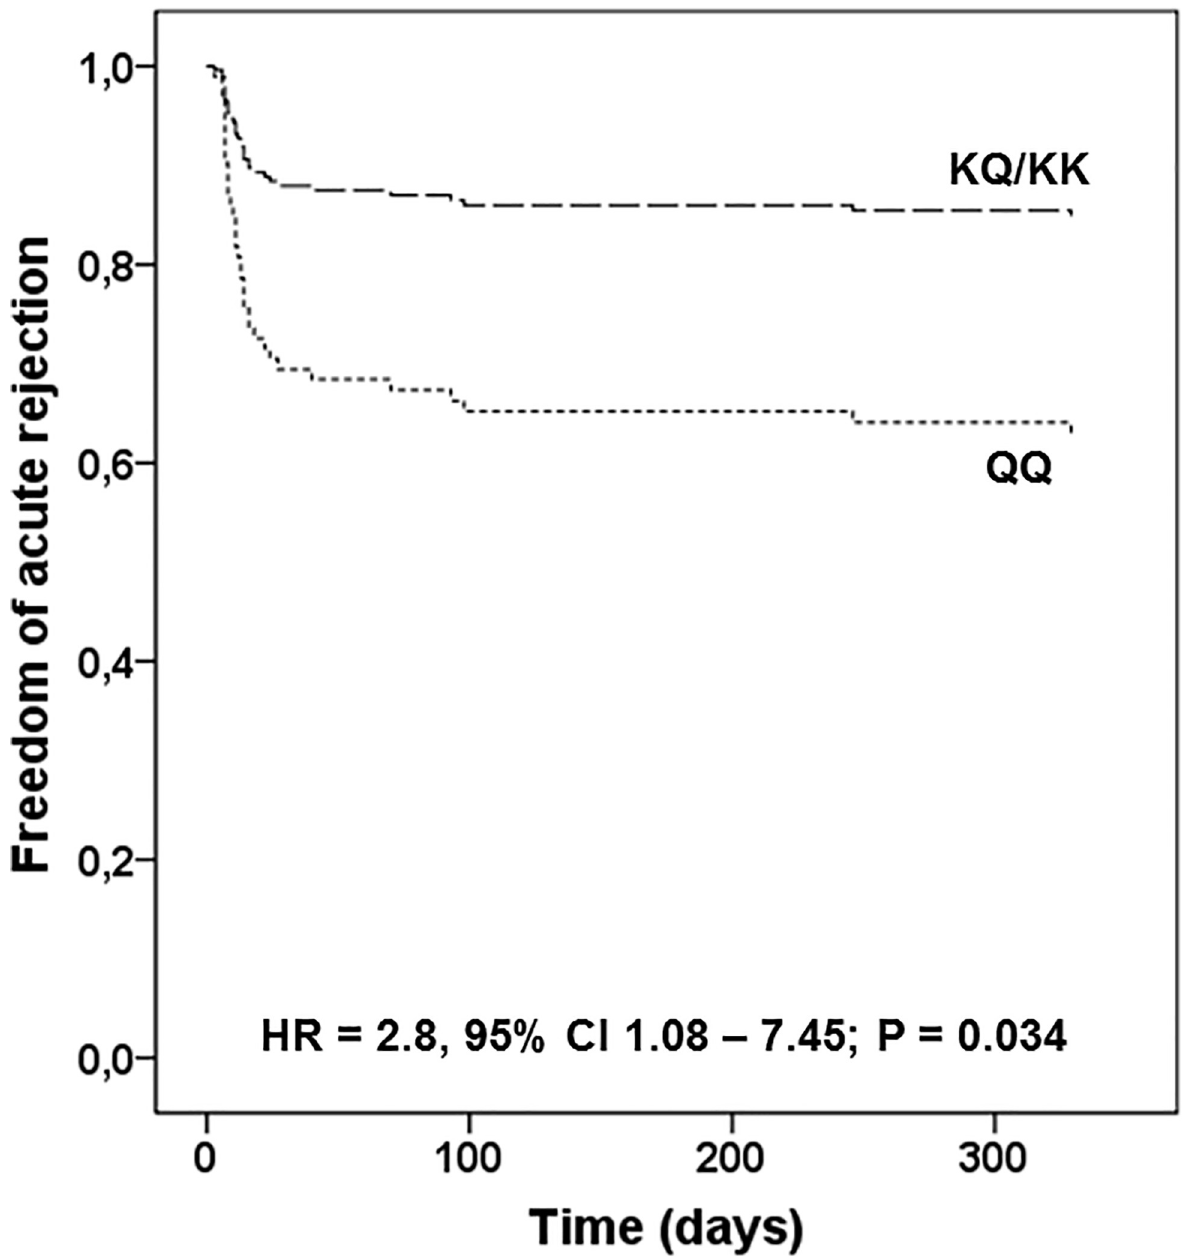
Fig 1. Cox regression analysis of the ENPP1 K121Q polymorphism and acute rejection (AR) episodes in kidney transplant recipients. Adjusted for HLA-DR, pregnancies, blood transfusions, recipient age, delayed graft function, and induction therapy.